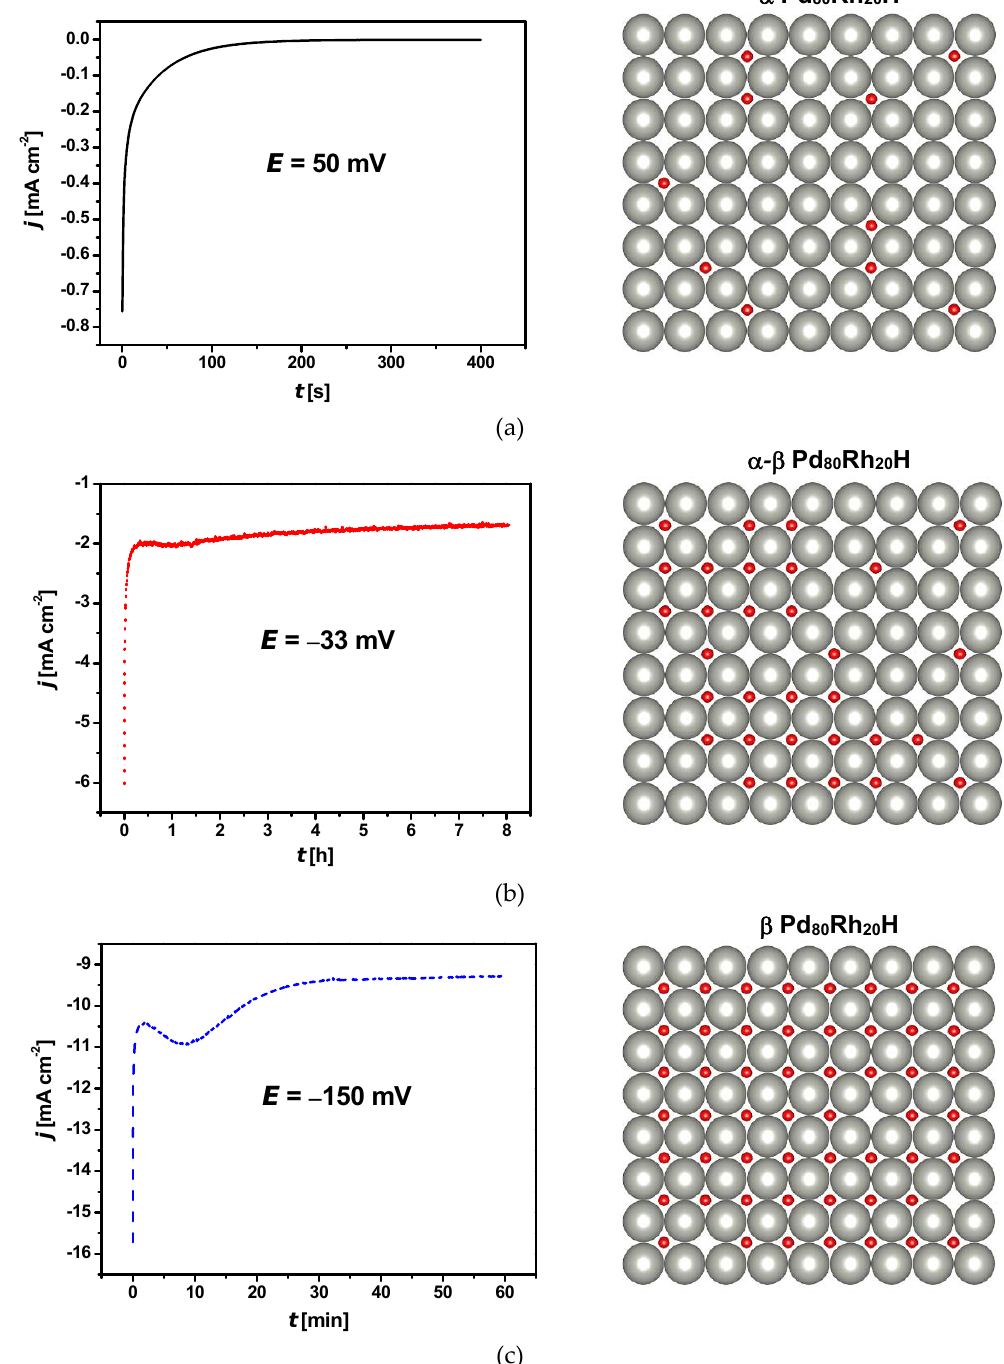
Figure 4. Chronoamperometric curves for hydrogen electrosorption, registered at a 50 µ m Pd 80 Rh 20 foil in 0.1M H 2 SO 4 at different potentials corresponding to: ( a ) α phase; ( b ) α‐β phase transition; ( c ) β phase. The absorbed hydrogen atoms in the corresponding structures are depicted in red.